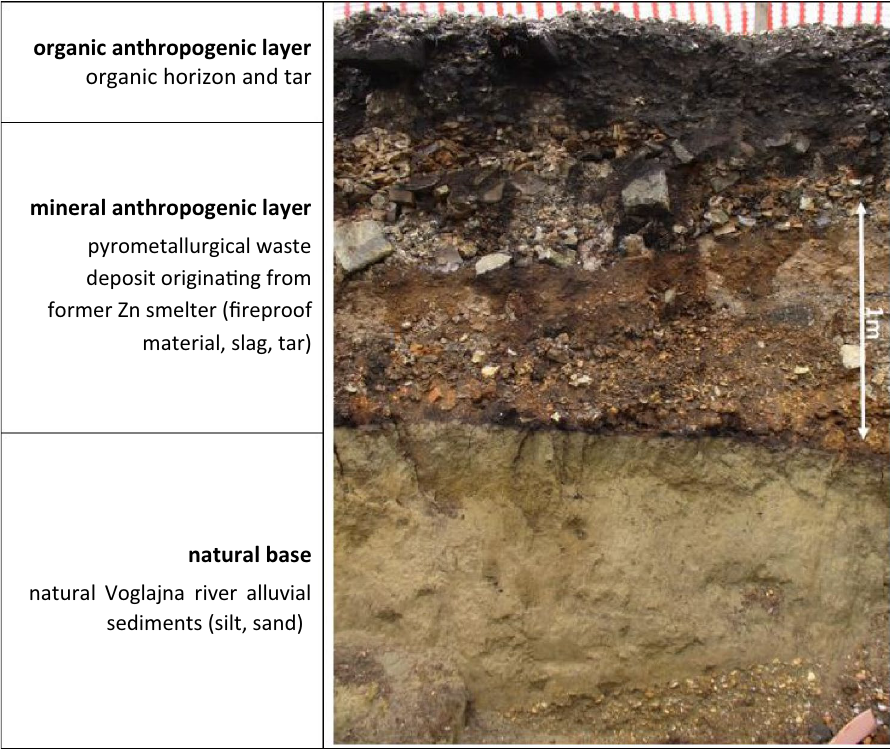
Figure 5. The characteristic profile through pyrometallurgical waste deposit (photo G. Žibret). The thickness of organic and mineral anthropogenic layers and their order of appearance in the profile can vary through the